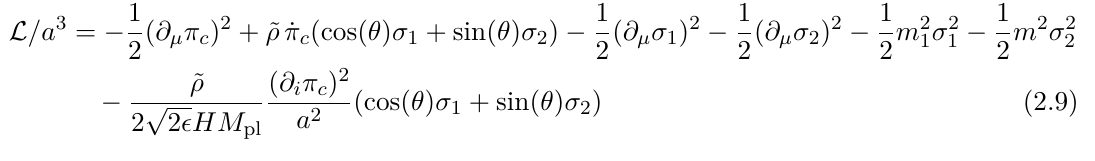
JHEP12(2022)137